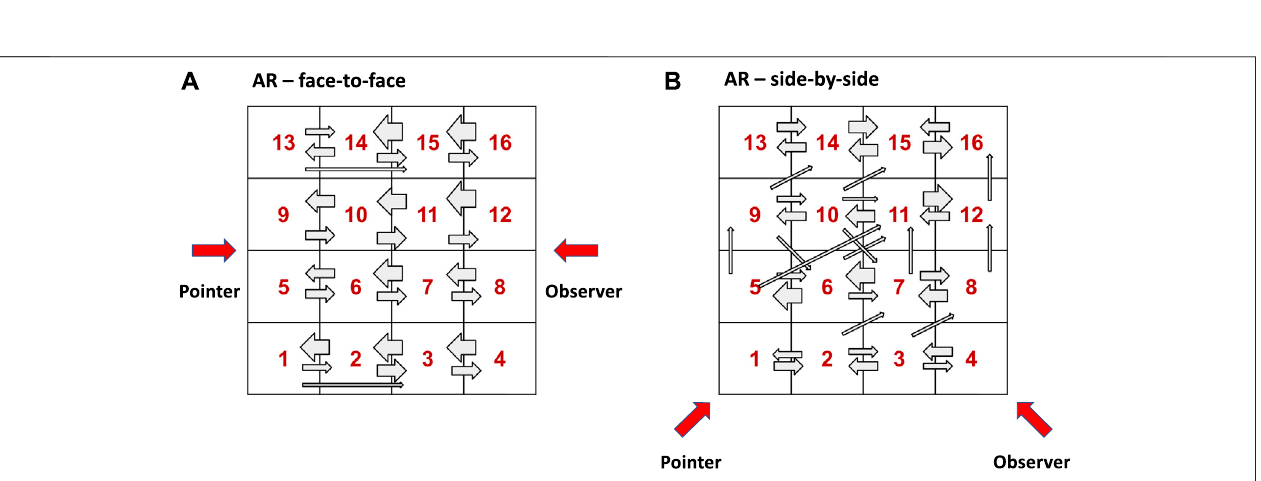
Figure 8 -Left indicates that one observer chose 3 when the pointer pointed at 1 in the AR/face-to-face condition. The biggest arrow in Figure 8 -Left represents six errors, and the biggest arrow in Figure 8 -Right represents fi ve errors. In the case of the AR/face-to-face condition, all errors are horizontal, and all of them except two cases are off-by-one errors. In general, the left-facing arrows are broader than the right- facing arrows. This indicates that more observers made errors in which they chose a cube further away from them, picking cubes closer to the pointers than the ones that the pointers were actually pointing at. One possible explanation for this trend is that nger (i.e., using an imaginary ray extending from a fi ngertip to